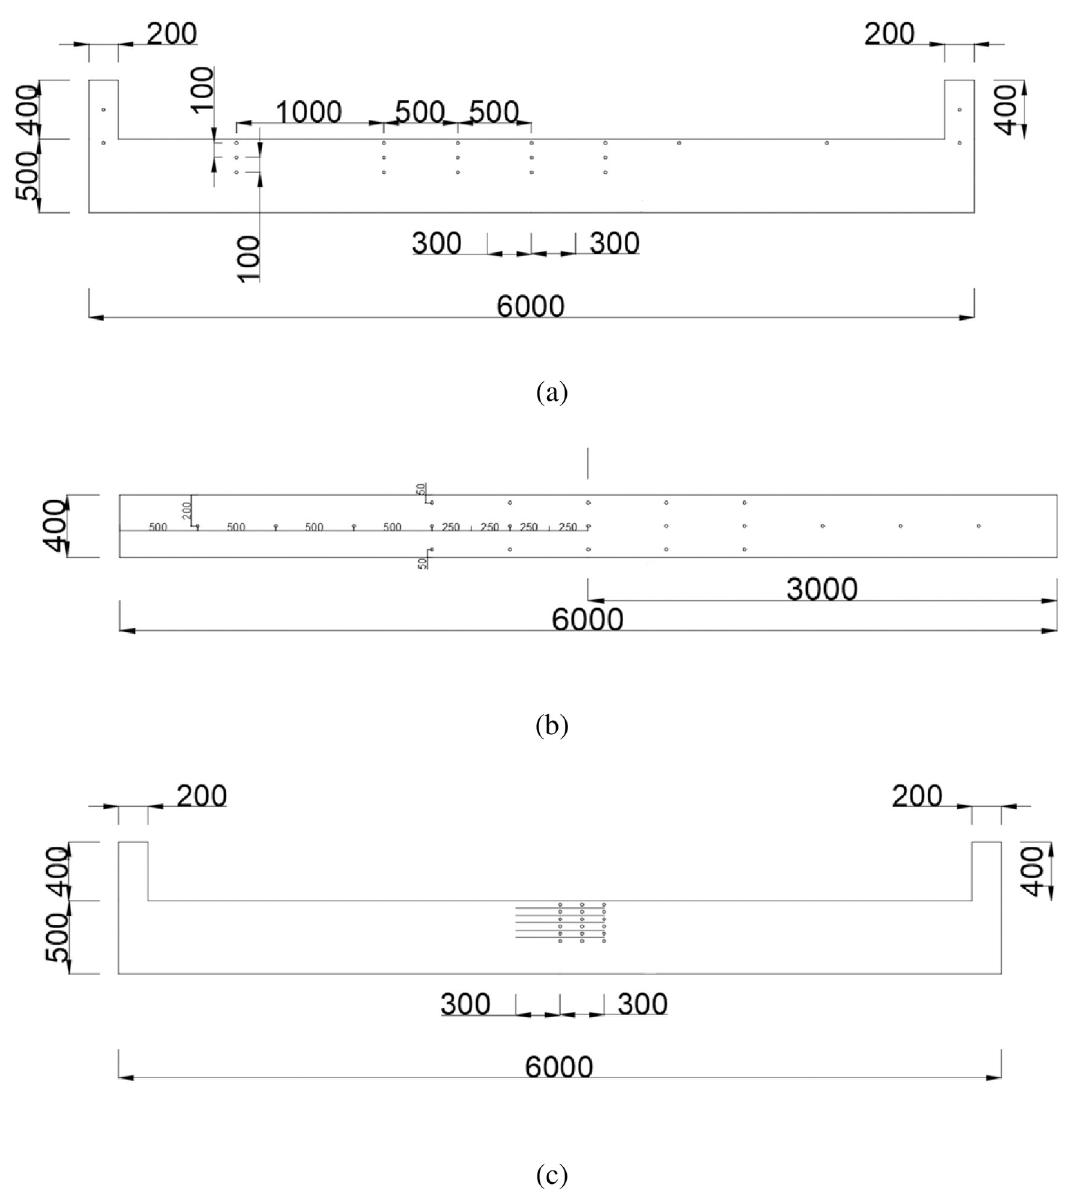
Fig 2. The layout of